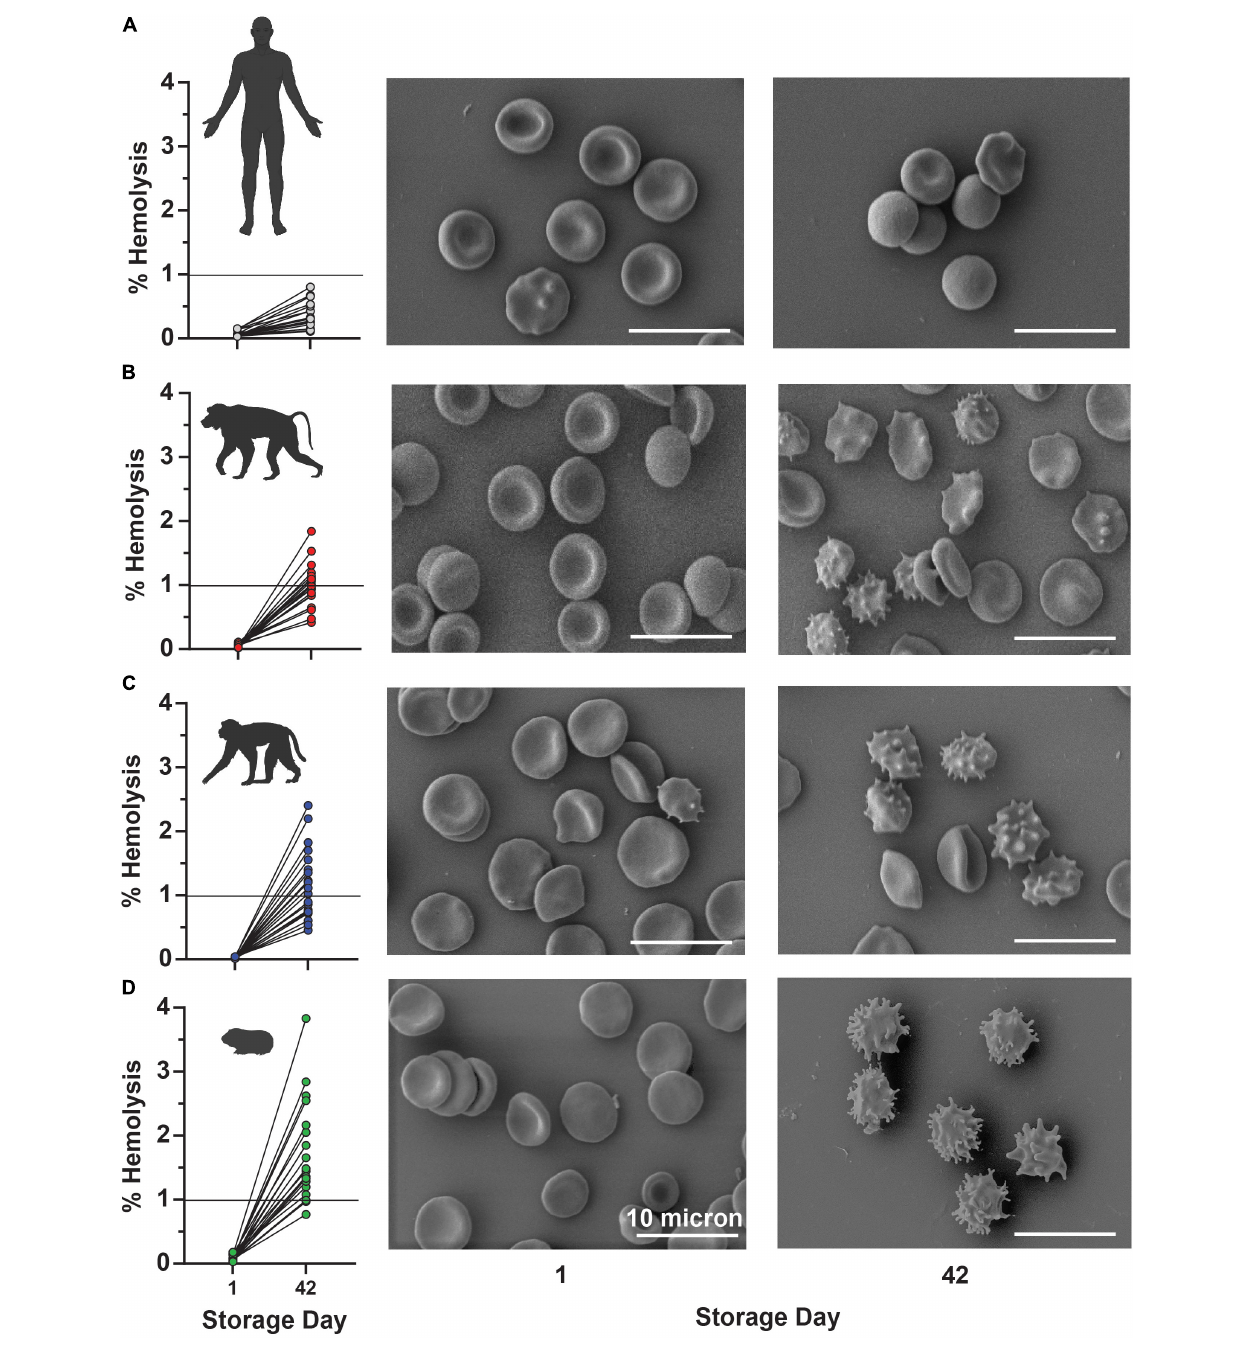
FIGURE 9 | End-of-storage spontaneous hemolysis measurements are directly compared to scanning electron micrographs in fresh (left panels) and 42-day stored (right panel) RBCs from humans (A) , baboons (B) , macaques (C) , and guinea pigs (D) .